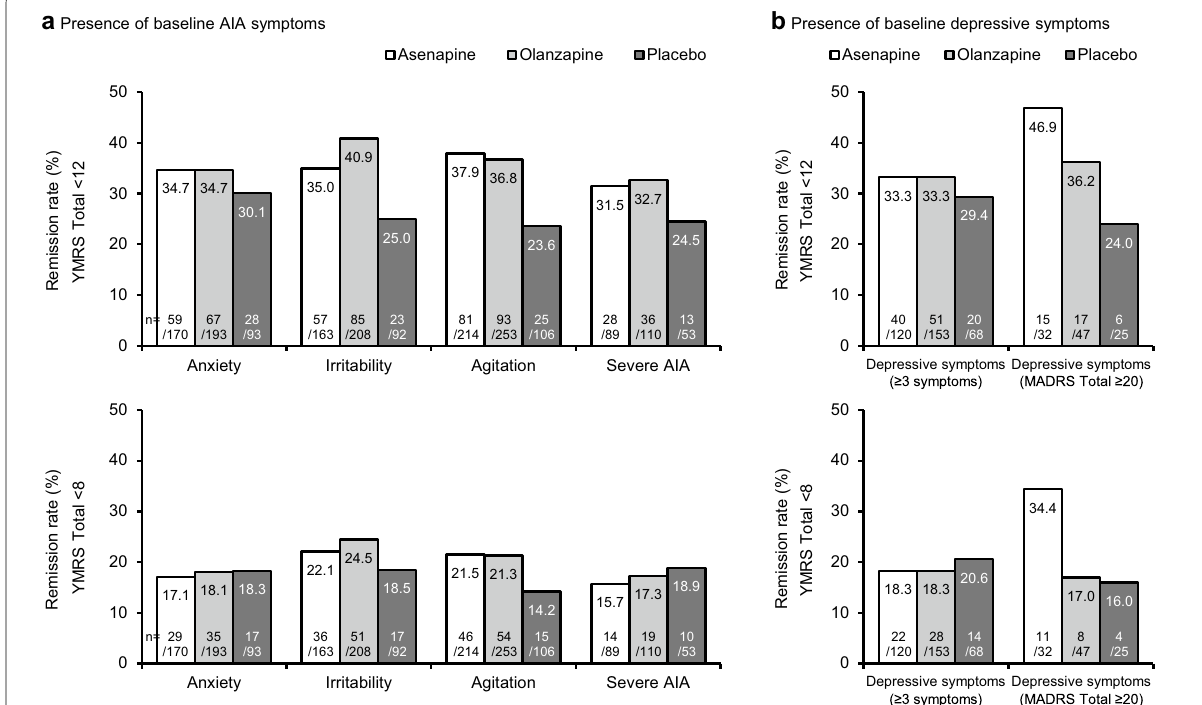
Fig. 4 Incidence of remission by treatment group in BD-I mania, stratified by baseline AIA/depressive symptoms. Anxiety was defined as a PANSS anxiety item score of 3 at baseline. Irritability was defined as a YMRS irritability item score of 4 at baseline. Agitation was defined as a YMRS ≥ ≥ increased motor activity–energy item score of 3 at baseline. Severe AIA was defined as meeting the above criteria for all three AIA symptoms. ≥ Patients missing a value for the corresponding symptom at baseline were not included in the analysis. Two definitions were used for remission: a YMRS Total score of <12 at Day 21 (upper figures); and a YMRS Total score of <8 at Day 21 (lower figures) (observed cases). Depressive symptoms were defined in two ways: 3 individual MADRS items with a score of 1, or a MADRS Total score of 20 at baseline. AIA, anxiety, irritability, and agi- ≥ ≥ ≥ tation; BD-I, bipolar I disorder; MADRS, Montgomery–Åsberg Depression Rating Scale; PANSS, Positive and Negative Syndrome Scale; YMRS, Young Mania Rating Scale. a Presence of baseline AIA symptoms and b presence of baseline depressive